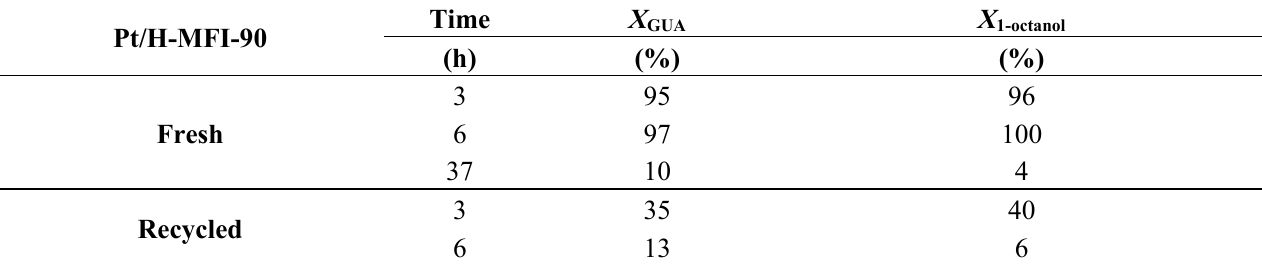
Table 3. Comparison of the catalytic performance between fresh and